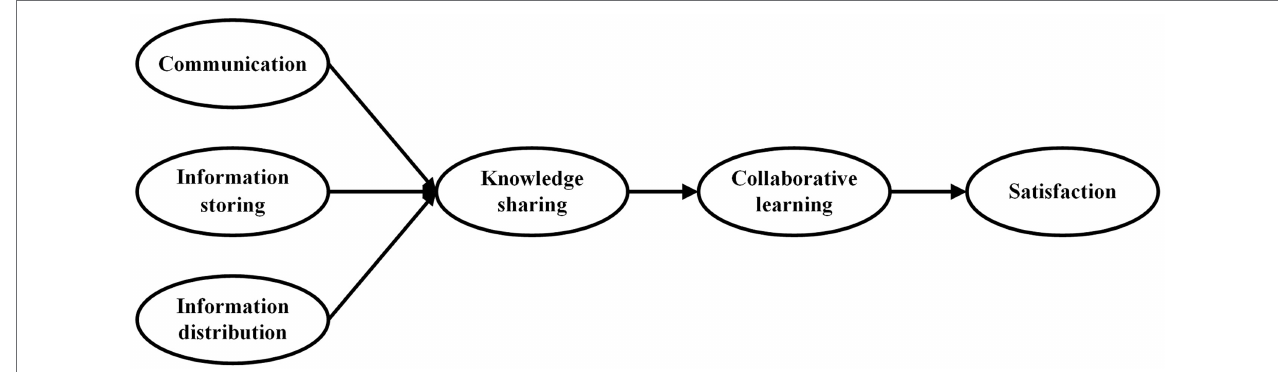
FIGURE 1 | Theoretical